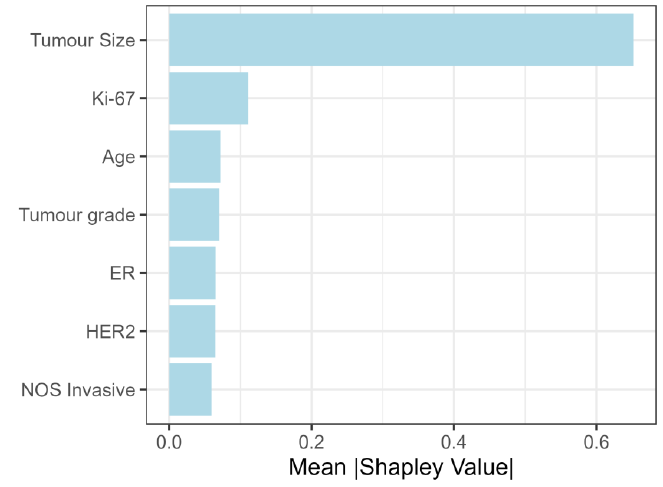
Figure 6. Shapley values (feature importance) for total study population.